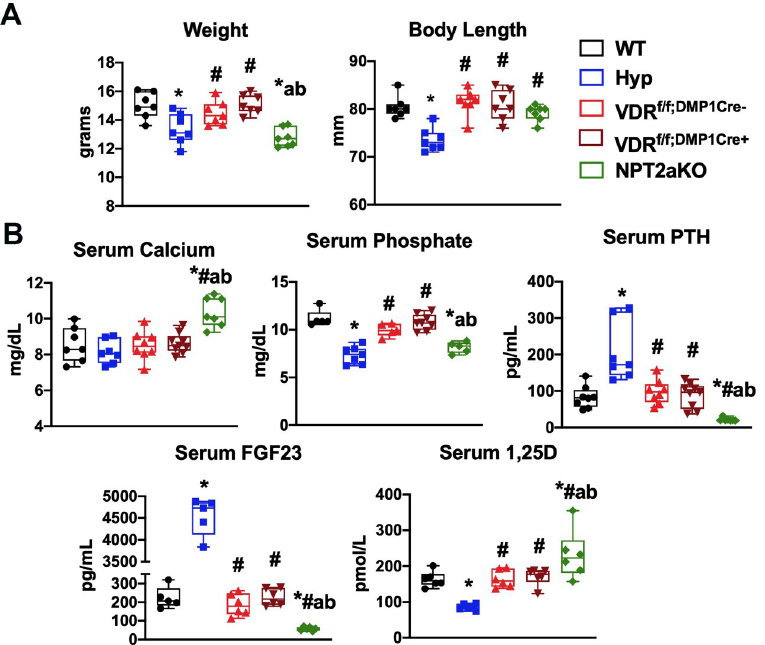
Fig 2. Body weight and length and serum parameters for VDR f/f;DMP1Cre+ , NPT2aKO, and control mice. (A) Body weight and length and (B) serum mineral ions and hormones were measured for d30 WT, Hyp, VDR f/f;DMP1Cre- , VDR f/f;DMP1Cre+, and NPT2aKO mice. For weight, body length, and serum calcium and PTH, data are representative of that obtained from at 7–9 mice per genotype, with each group including 3–5 mice of either sex. For serum phosphate, FGF23, and 1,25D, data are representative of at least 5 mice per genotype, with each group including 2–4 mice of either sex. � p < 0.05 vs WT, # p < 0.05 vs Hyp, a p < 0.05 vs VDR f/f;DMP1Cre- , b p < 0.05 vs VDR f/f;DMP1Cre+ .